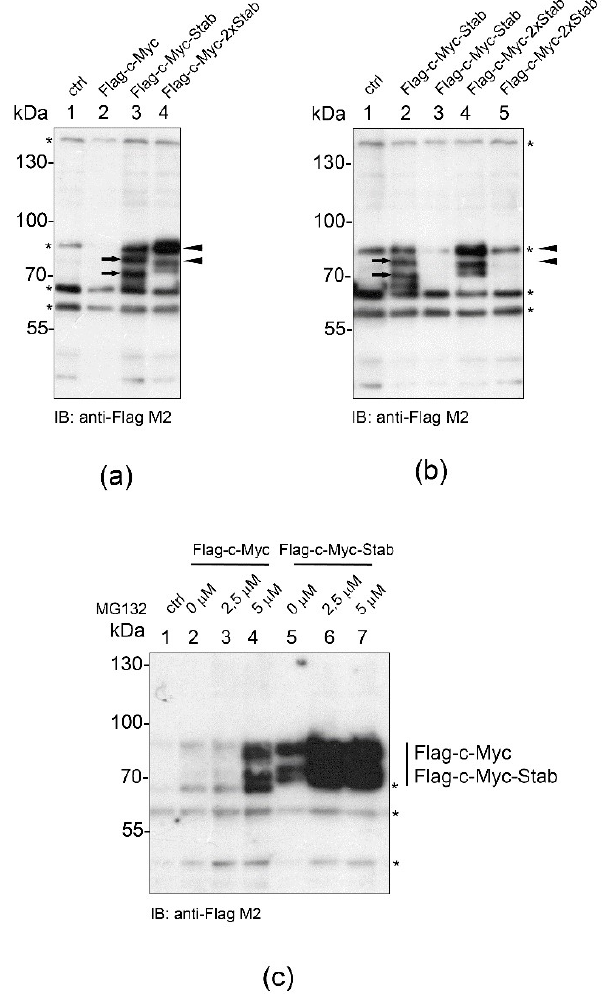
Figure 3. STABILON transiently stabilizes the transcription factor c-Myc. ( a ) Stably transfected CHO-K1 cells expressing Flag-c-Myc (lane 2), Flag-c-Myc-Stab (lane 3) or Flag-c-Myc-2 × Stab proteins (lane 4), respectively, were induced by doxycycline treatment for 24 h and analyzed by immunoblotting. Total protein extract of non-transformed CHO-K1 cells serves as negative control (lane 1). Arrows indicate Flag-c-Myc-Stab, while arrowheads mark the Flag-c-Myc-2 × Stab proteins. Non-specific bands (marked by asterisks) serve as loading control. ( b ) Stably transfected CHO-K1 cells expressing Flag-c-Myc-Stab (lanes 2 and 3) or Flag-c-Myc-2 × Stab proteins (lanes 4 and 5) were induced by doxycycline treatment for 24 h. Flag-c-Myc-Stab (lane 3) and Flag-c-Myc-2 × Stab (lane 5) cells were further incubated in doxycycline-free medium for 24 h before subjected to immunoblotting using anti-FlagM 2 monoclonal antibody. Arrows mark Flag-c-Myc-Stab, while arrow heads indicate the Flag-c-Myc-2 × Stab proteins. Non-specific bands (marked by asterisks) serve as loading control. Protein extract of non-transformed CHO-K1 cells serves as negative control (lane 1). ( c ) Stably transfected CHO-K1 cells expressing the Flag-c-Myc (lanes 2–4) or Flag-c-Myc-Stab (lanes 5–7) proteins were grown in the presence of doxycycline for 10 h, and 4 h post induction cell culture media were supplemented with 0 µM (lanes 2 and 5), 2.5 µM (lanes 3 and 6) or 5 µM (lanes 4 and 7) of MG132 proteasome inhibitor. Total protein extracts were fractionated on SDS-PAGE and analyzed by immunoblotting. Protein extract of CHO-K1 cells is shown as control (lane 1), while non-specific bands (marked by asterisks) serve as loading control.